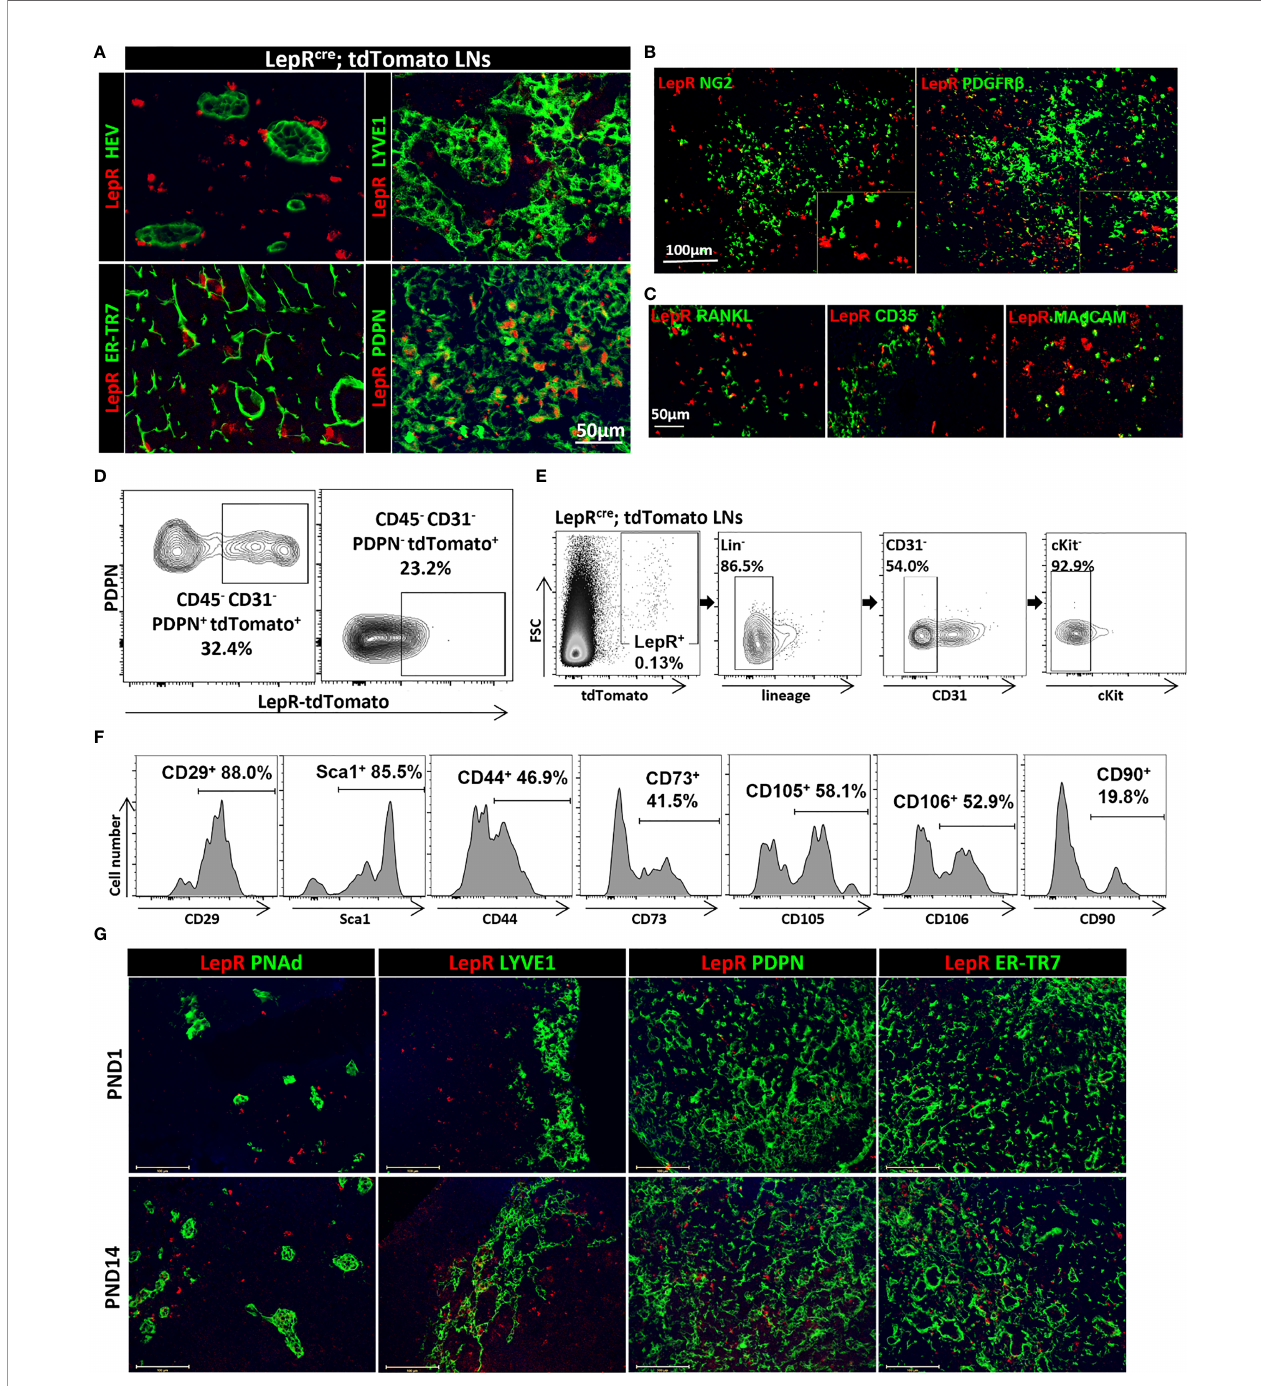
FIGURE 1 | (A) Fluorescence micrographs show circumferential distribution of LepR + cells (red) around HEVs and lymphatics in Lepr cre ;tdTomato mice LNs. LepR (red) colocalized with PDPN and ER-TR7. Scale bar, 50 m m. (B) Fluorescence micrographs of LNs from Lepr cre ;tdTomato mice showed no colocalization of LepR (red) with NG2 and PDGFR b . Scale bar, 100 m m. (C) Fluorescence micrographs of Lepr cre ;tdTomato mice LNs showed no colocalization of LepR (red) with RANKL, CD35 and MAdCAM. Scale bar, 50 m m. (D) LepR expression in CD45 - PDPN + CD31 - (FRCs) and CD45 - PDPN - CD31 - (DN) populations of LNs were evaluated by fl ow cytometry. Data are representative of three independent experiments (n=3). (E) Gating strategy to exclude hematopoietic and endothelial cells for LepR + cells in LepR cre ;tdTomato LNs. (F) The percentages of LepR + cells of LNs in stromal marker panel Sca-1, CD29, CD90, CD44, CD73, CD105 and CD106 were evaluated based on the gating strategy in (E) . Data are representative of three independent experiments (n=3). (G) Fluorescence micrographs of PND1 and PND14 LNs showed location of LepR + cells (red) in relation to HEVs, lymphatics, PDPN and ER-TR7. Scale bar, 100 m